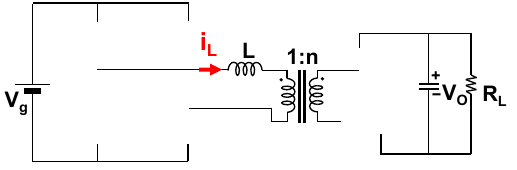
Figure 4. Lineal subcircuit of operation of SAB converter in DCM.